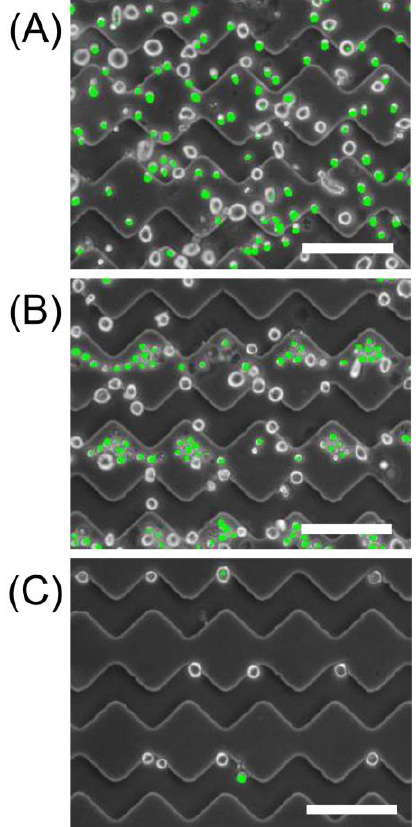
Figure 3. Phase contrast images during bone marrow-derived mesenchymal stem cells (BMSCs) separation and enrichment. The UE7T-13 cells and HL-60 cell suspensions were injected into the DEP device ( A ). The UE7T-13 cells were separated on the saw-shaped ITO electrodes after application of DEP with 5 Vpp at 30 kHz ( B ), and the HL-60 cells were washed out selectively under DEP ( C ). The HL-60 cells were stained with fluorescent reagent Live-Dye to identify the UE7T-13 cells. The concentrations of the UE7T-13 and HL-60 cells were 1.0 × 10 7 cells/mL and 2.0 × 10 7 cells/mL, respectively. The images were merged by binarized fluorescence images at the same field. Scale bars are 100 μm.